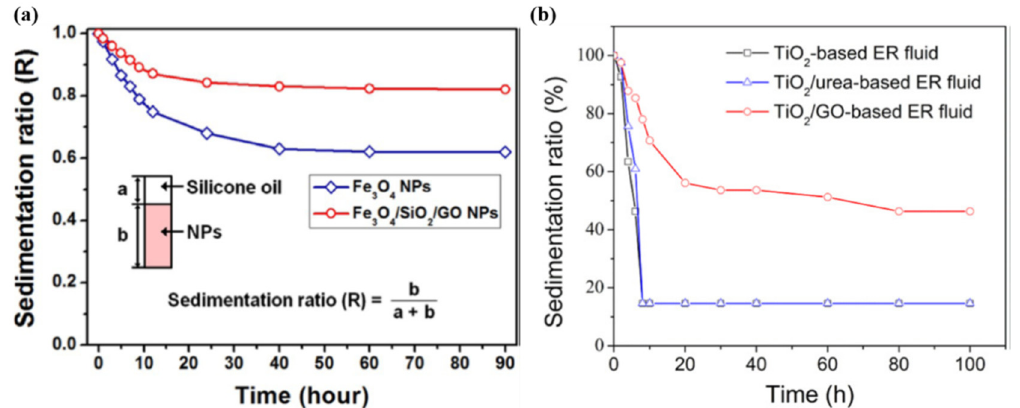
Figure 14. Sedimentation properties of ( a ) Fe 3 O 4 and Fe 3 O 4 / SiO 2 / GO-based ER fluids (25 vol.%) [64], ( b ) TiO 2 , TiO 2 / urea and TiO 2 / GO-based ER fluids (37 vol.%) [58].